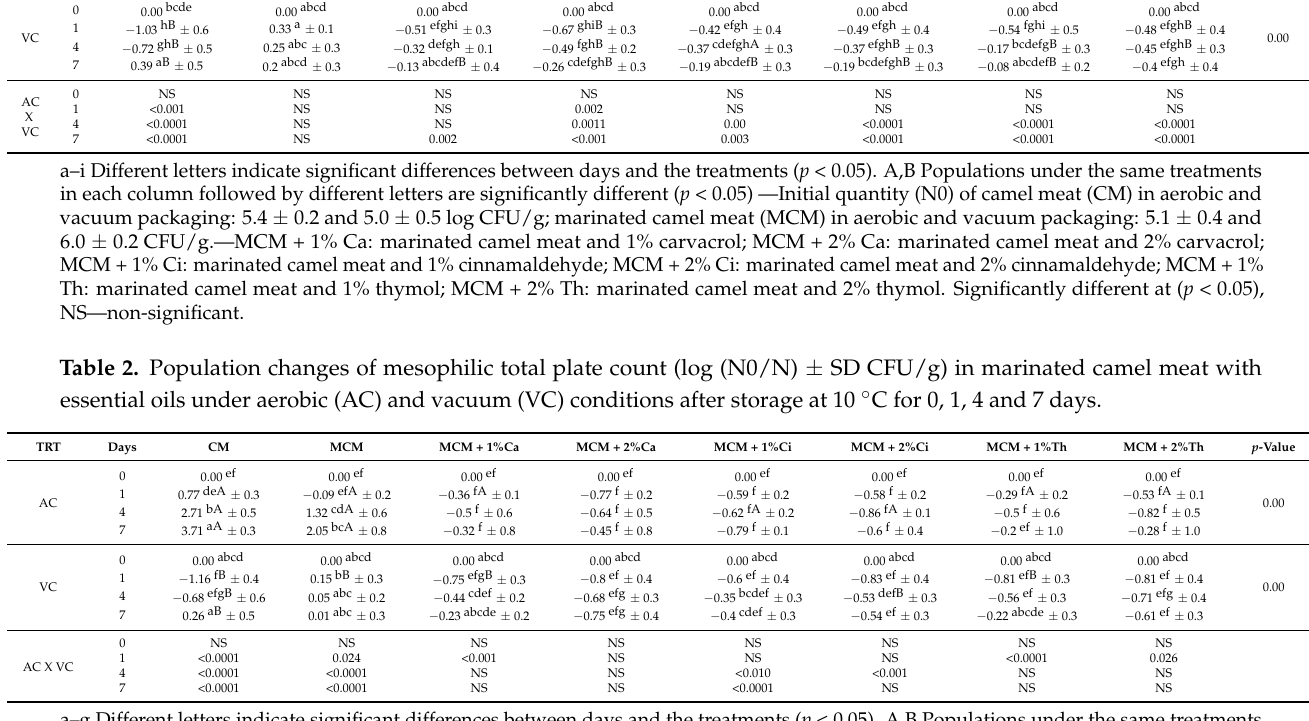
Table 1. Population changes of mesophilic total plate count (log (N0/N) ± SD CFU/g) in marinated camel meat with essential oils under aerobic (AC) and vacuum (VC) conditions after storage at 4 ◦ C for 0, 1, 4 and 7 days.